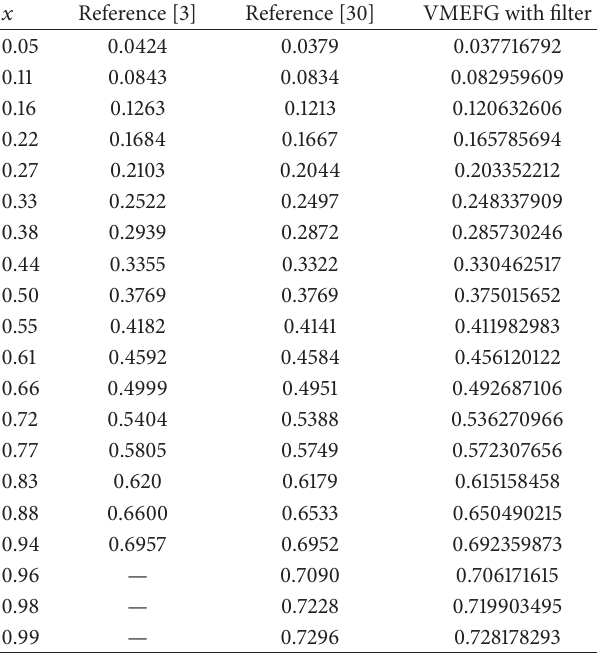
Table 2: Comparison between the numerical solutions at 𝑡 = 1.0 for Re = 10 4